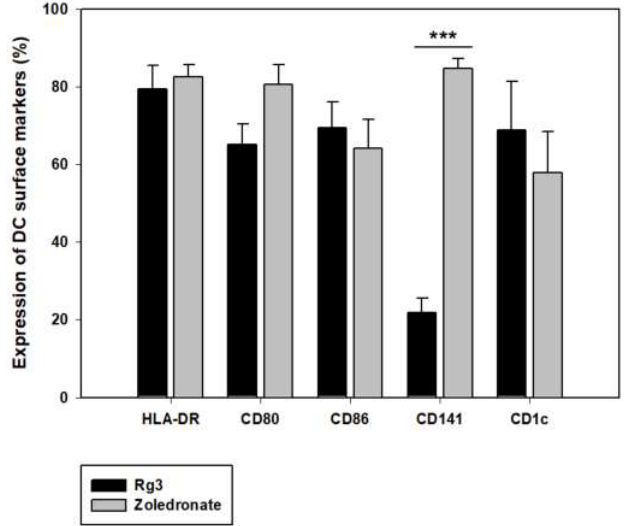
Figure 4. Effect of zoledronate on the differentiation and maturation of cDC1 in DC vaccine produc- tion. Effects of zoledronate in DC vaccine. In the process of DC vaccine production, 3 hr treatment with zoledronate induces differentiation and maturation of DC to cDC1 and yields a higher level of CD141 marker. Phenotype markers were analyzed by flow cytometry to compare Rg3 (n = 4) and zoledronate (n = 5), which were used for the induction of DC maturation. *** p < 0.001. Table 2. Effect of zoledronate treatment times (3 h and 24 h) on surface markers.